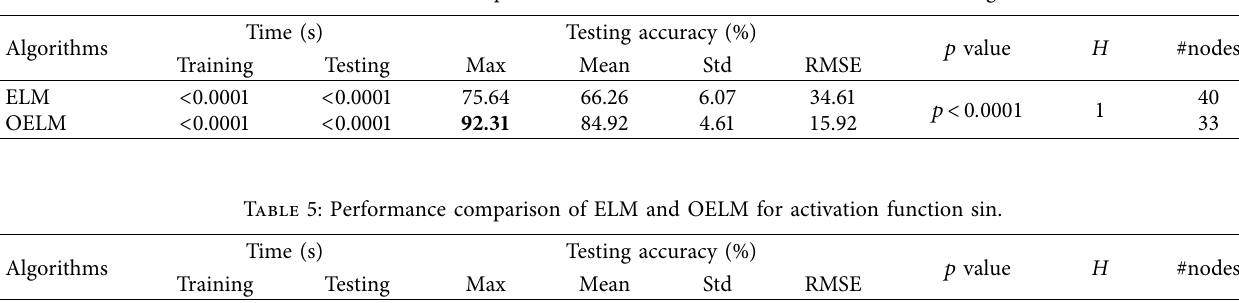
Figure 7: Classification accuracy of ELM and OELM with the same parameters. Table 4: Performance comparison of ELM and OELM for activation function sig.